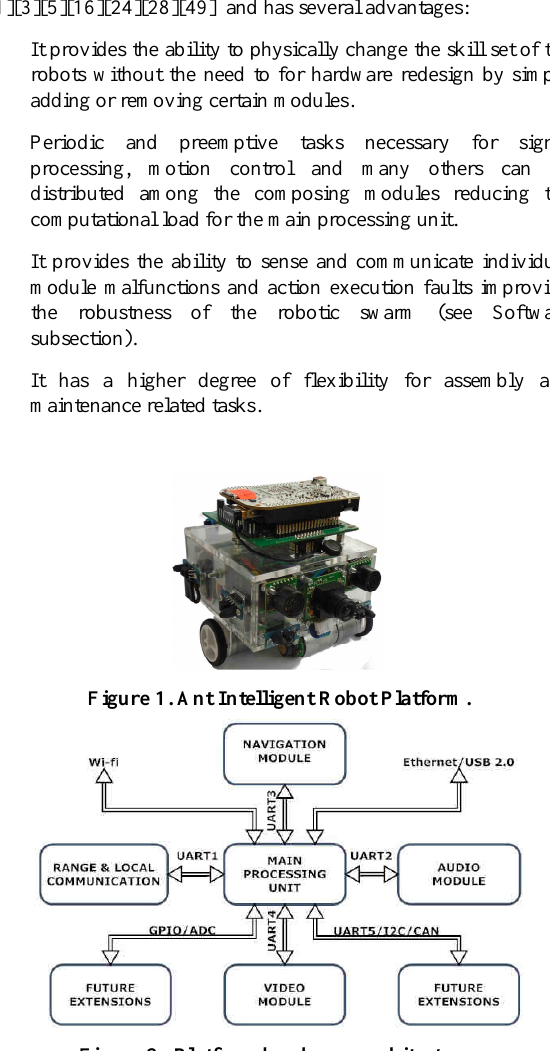
Figure 2. Platform hardware architecture.